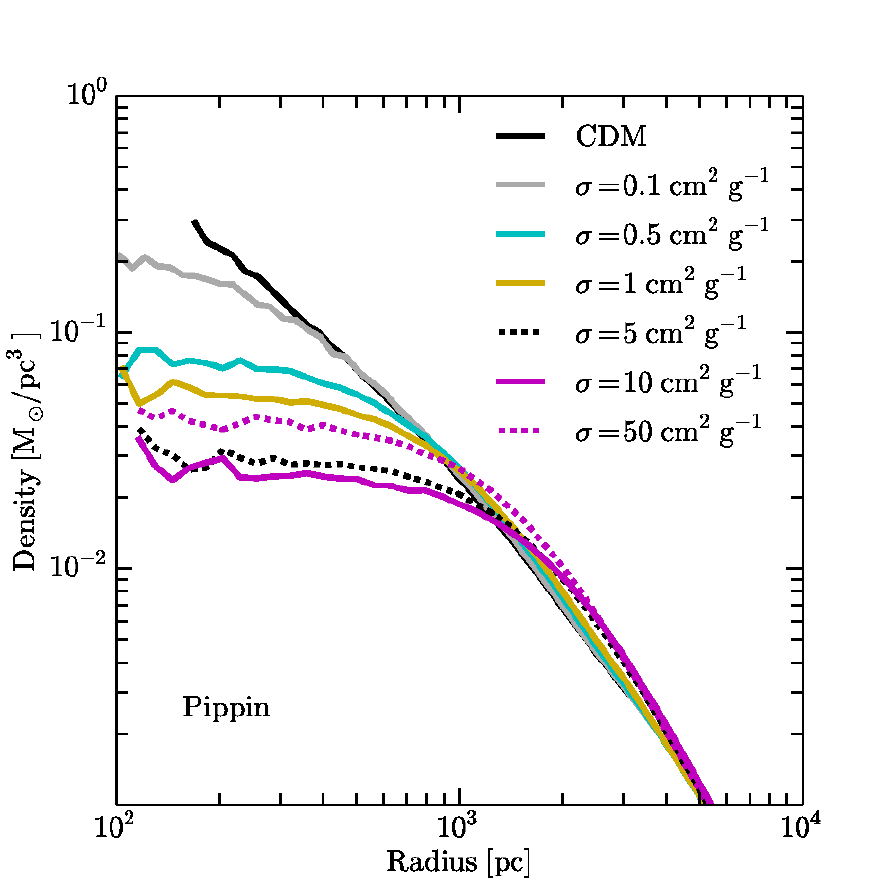
Figure 18. Inner density profile of a dark-matter halo with M halo = 0.9 × 10 10 M (cid:12) in collisionless CDM and in SIDM for different values of σ / m . The figure is reproduced from